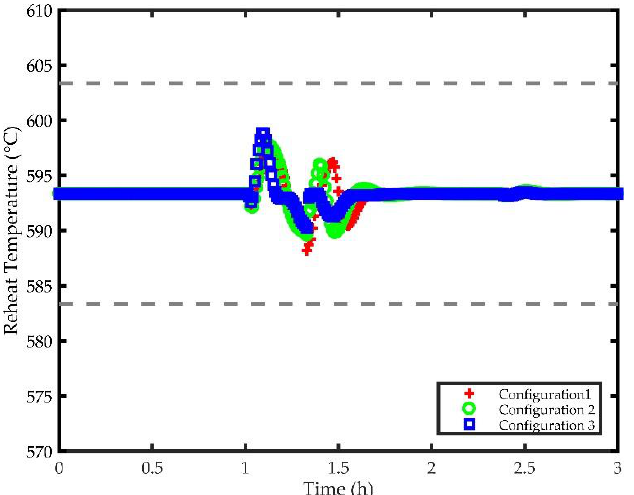
Figure 14. Response of Reheat Temperature for Different Control Strategies. Processes 2018 , 6 , x FOR PEER REVIEW